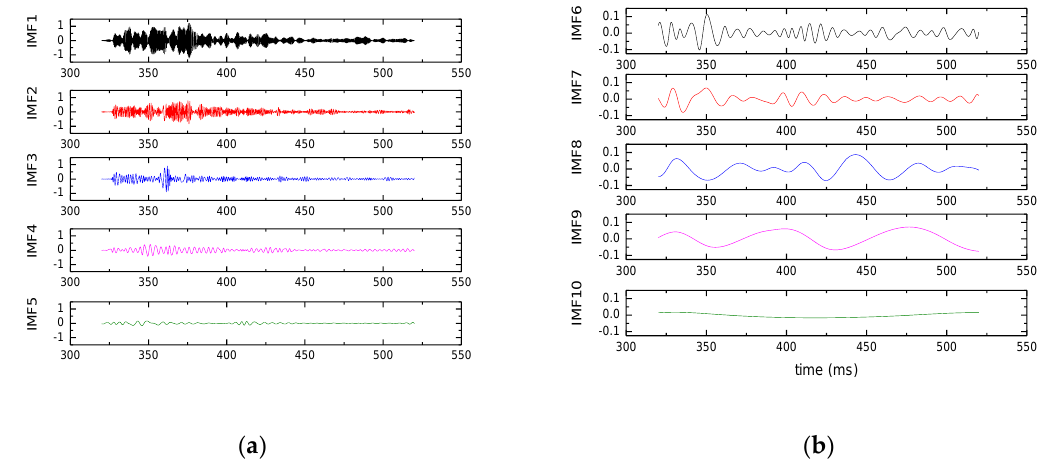
Figure 10. IMF components obtained by EMD. ( a ) IMF 1 to IMF 5 , ( b ) IMF 6 to IMF 10 .